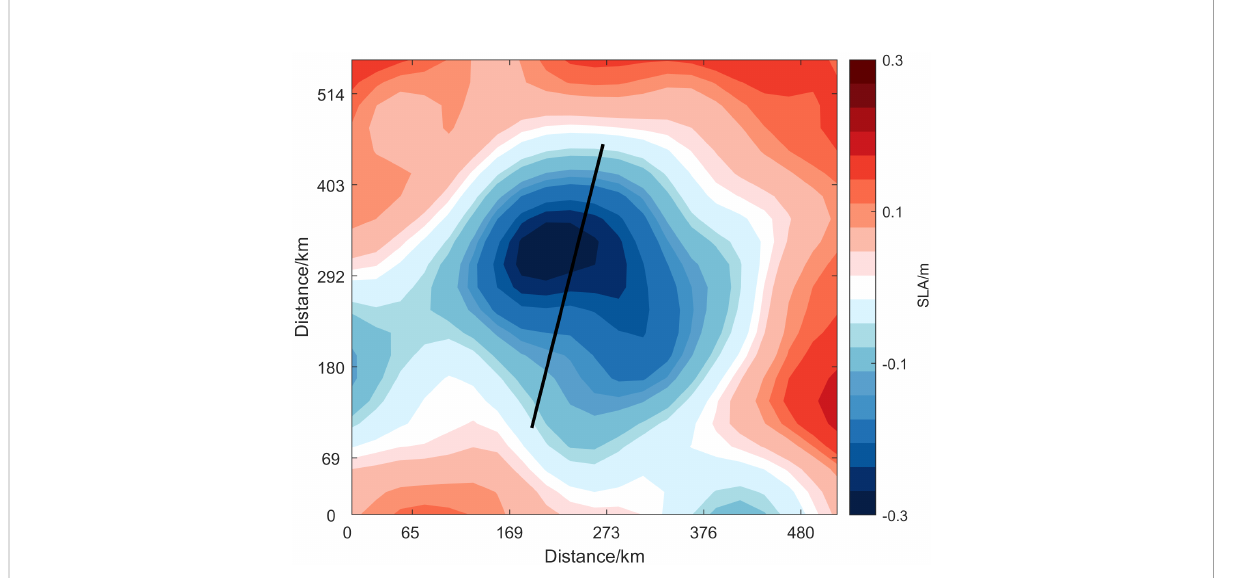
FIGURE 8 The distribution of the sea surface level anomalies on November 8, 2020 (unit: m). The black line represents the observation route of the Northwest Paci fi c survey